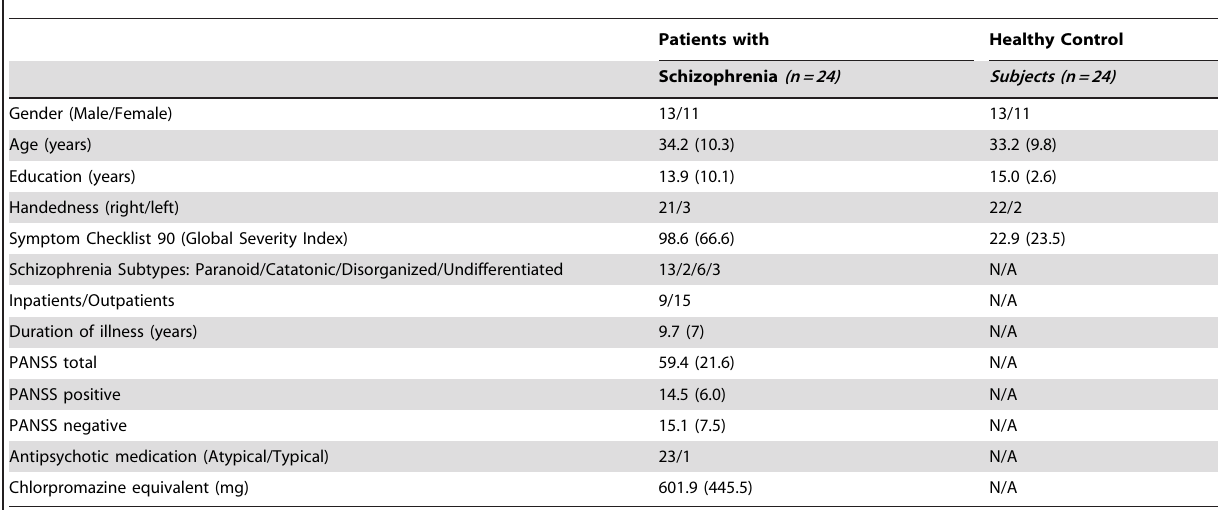
Table 2. Basic demographic and descriptive characteristics of the two study groups.